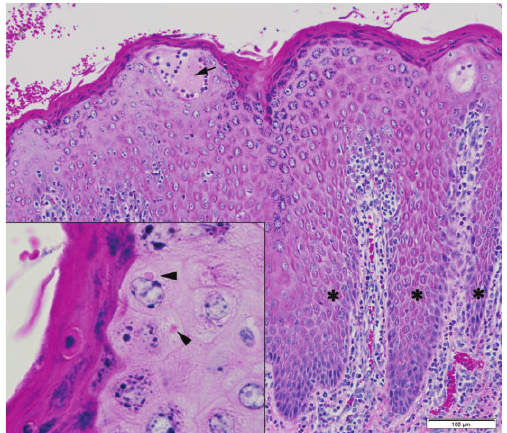
Figure 5: Haired skin, lip commissure. Epithelial hyperplasia ( ∗ ) with increased thickness up to 10 times normal (acanthosis) with prominent intracellular clear spaces/bridging (spongiosis), anasto- mosing rete ridges, and a vesicle (arrow). Inset: rarely keratinocytes contain one or more 2–10 𝜇 m round, brightly eosinophilic intracy- toplasmic inclusion bodies (arrowheads). Hematoxylin and eosin stain, 20x